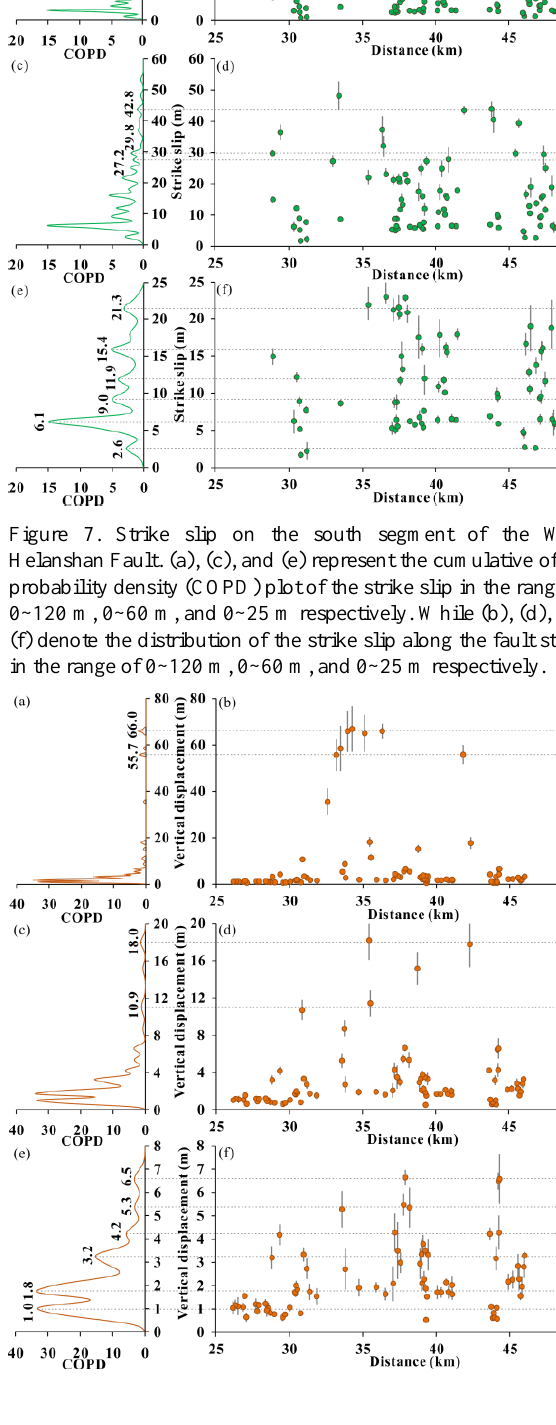
Figure 6. Vertical displacement on the middle segment of the West Helanshan Fault. (a), (c), and (e) represent the cumulative offset probability density (COPD) plot of the vertical displacement in the range of 0~60 m, 0~20 m, and 0~8 m respectively. While (b), (d), and (f) denote the distribution of the vertical displacement along the fault strike in the range of 0~60 m, 0~20 m, and 0~8 m respectively.